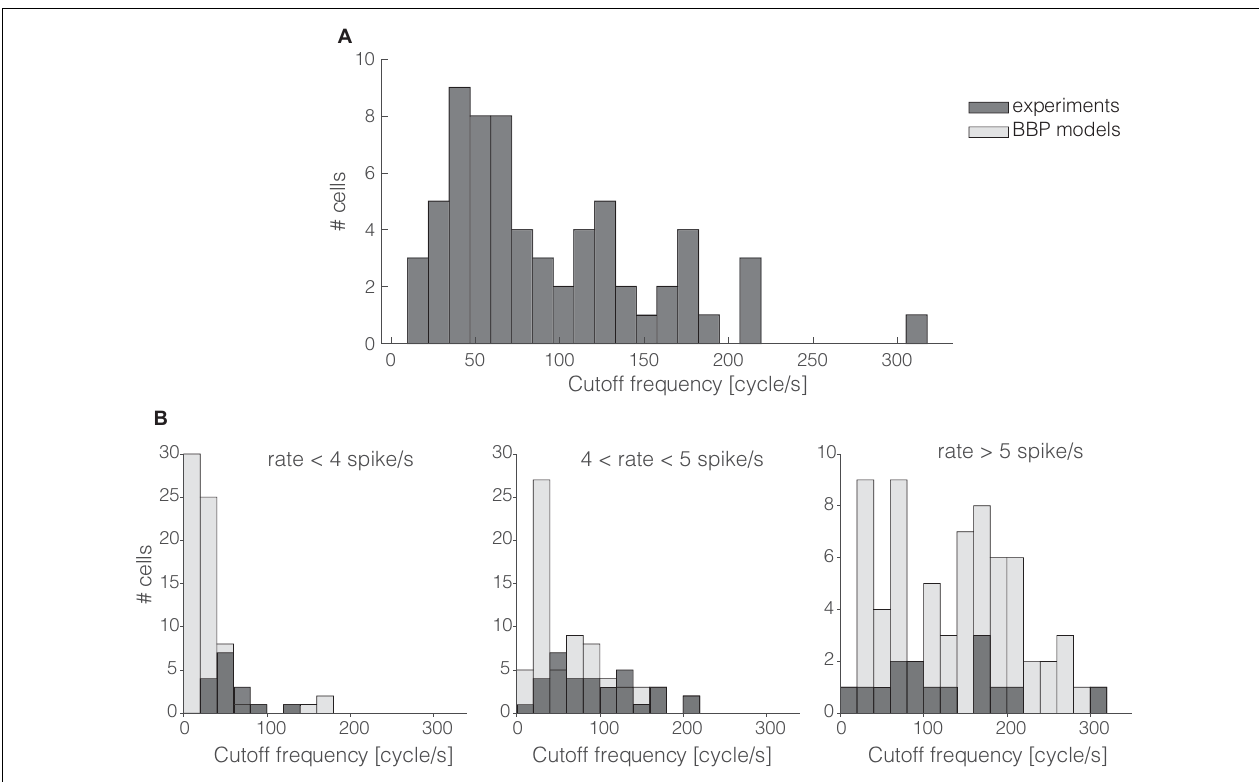
FIGURE 2 | The cells’ cutt off frequency distribution. More than 60% of the 65 interneurons recorded in this work had their cut off frequencies markedly below 100 cycle/s (A) . The same trend was quantitatively confirmed in silico by repeating the same protocol as that of Figures 1B–E in 69 L1 neuron models (B) as released by the Blue Brain Project (BBP). Numerical simulations and experimental data were compared over three distinct ranges of experimental firing rates, where models were set to fire at precisely 3, 5, and 7 spike/s ( B ; from left to right). The histogram overlay displays the rather good model predictions of the horizontal span of cut off frequencies over the three distinct firing